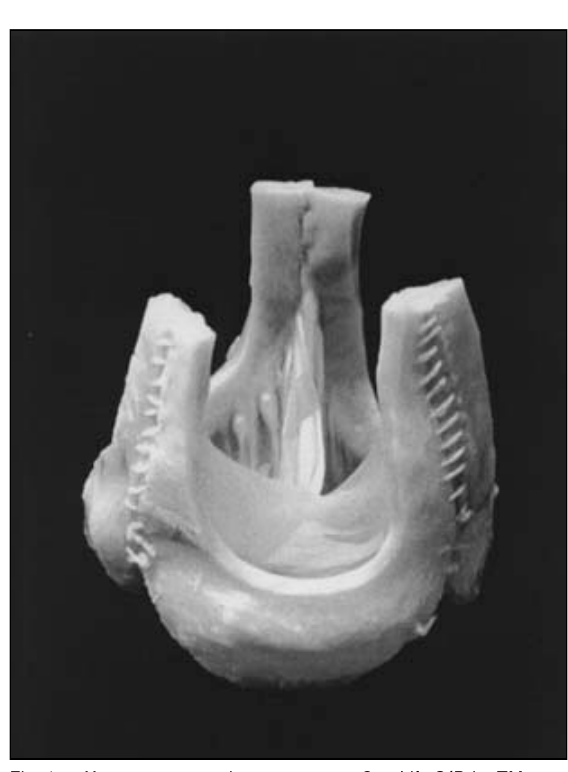
Fig. 1 - Xenoenxerto porcino sem suporte CryoLife O·BrienTM com- posto de 3 folhetos nªo coronarianos (reproduzida com permissªo do Dr. Mark F.